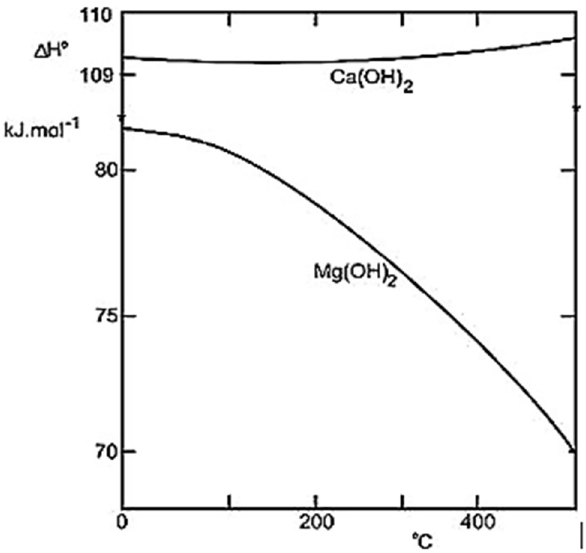
Figure 5. Enthalpy of dehydration reaction is dependent on temperature for Ca(OH) 2 and Mg(OH) 2 [39].